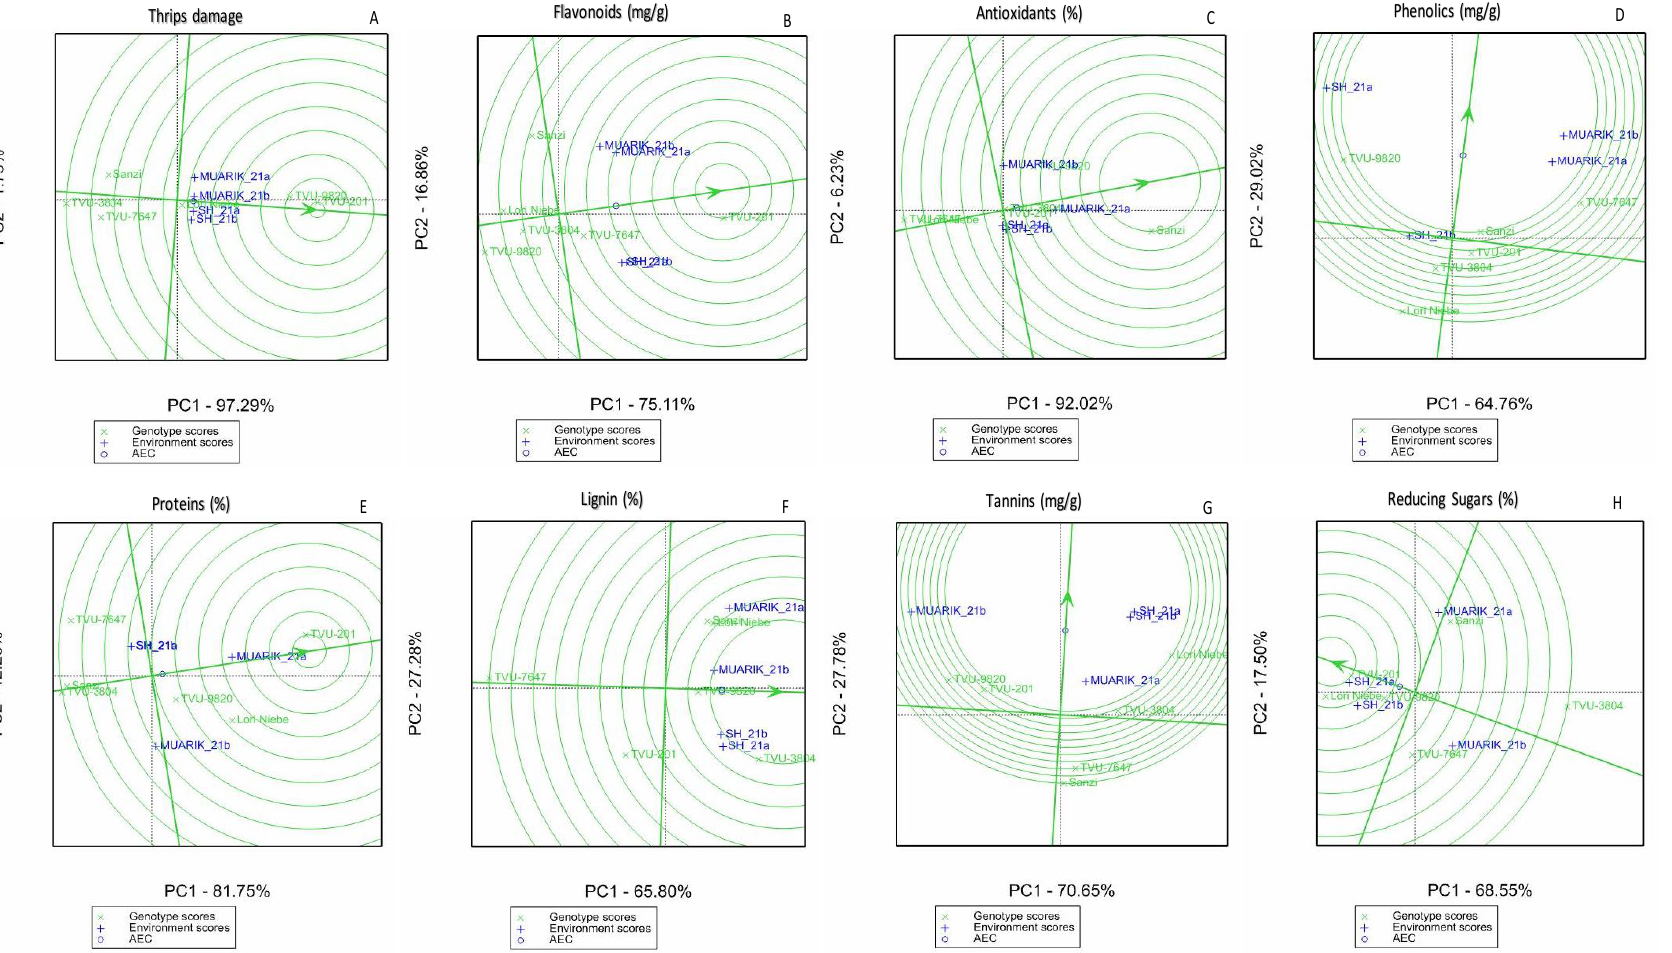
Figure 5. GGE biplot showing the ranking of genotypes based on the ideal genotype for flower bud thrips damage ( A ), flavonoids ( B ), antioxidants ( C ), phenolics ( D ), proteins ( E ), lignin ( F ), tannins ( G ) and reducing sugars ( H ) tested in cowpea across four environments in Uganda.